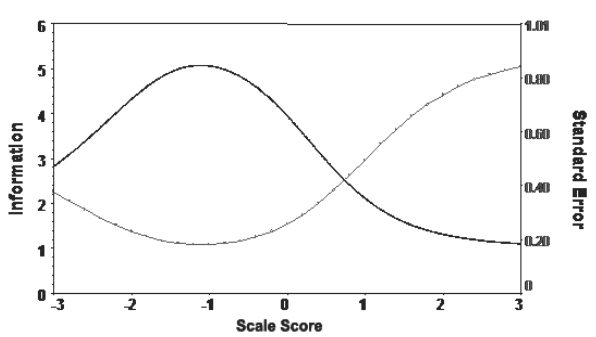
Figure 3 – Item Information and measurement error curve (2nd